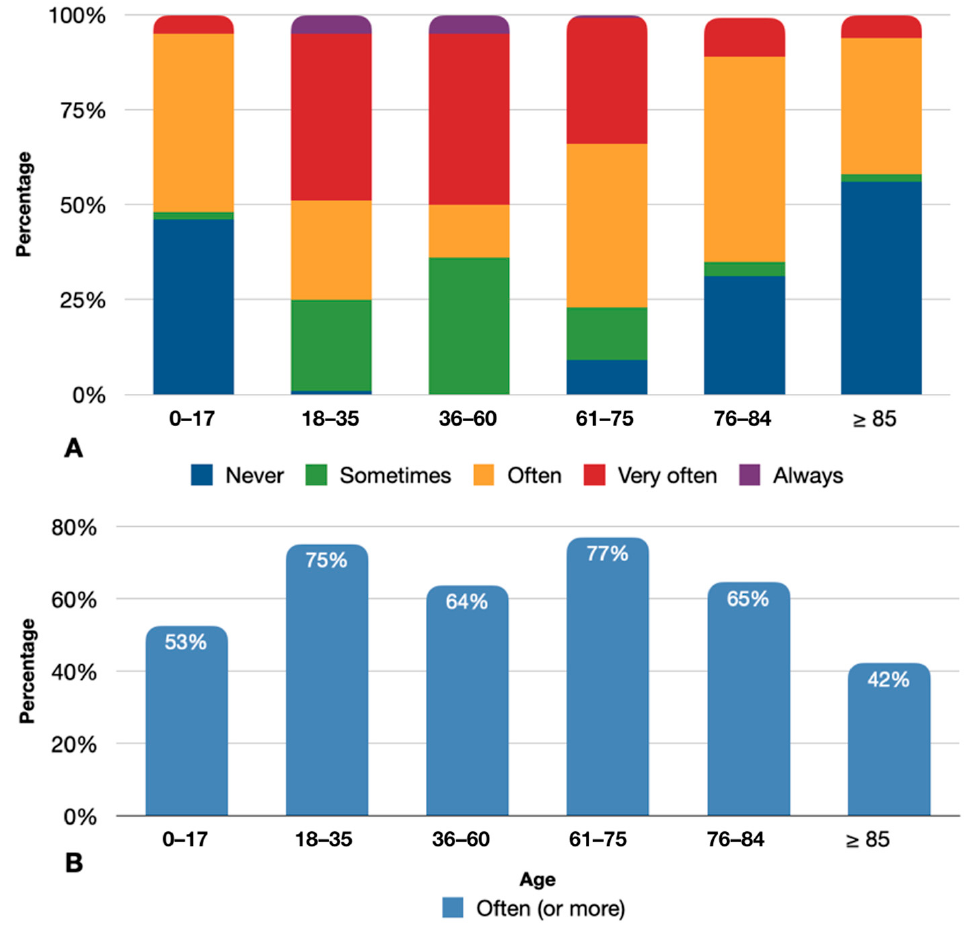
Figure 2. ( A ) Frequency of decongestant nasal spray use stratified by age groups. ( B ) Percentages of frequent users for each age group.